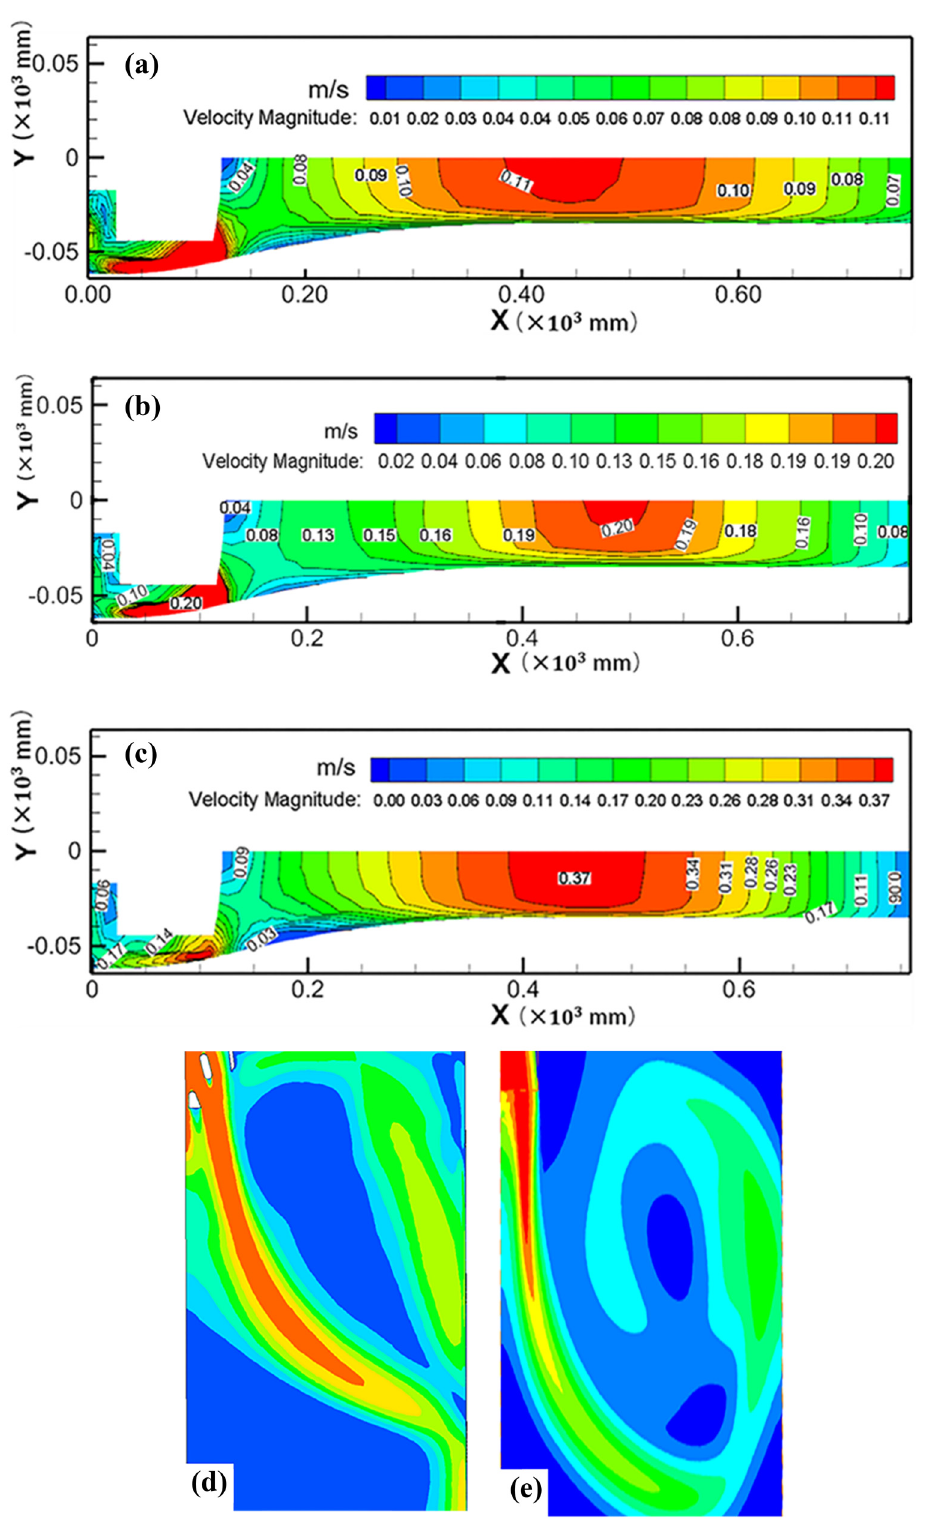
Figure 12: Surface velocity distribution of funnel mold at di ff erent casting speeds and cloud image of fl uid fl ow in the funnel mold: